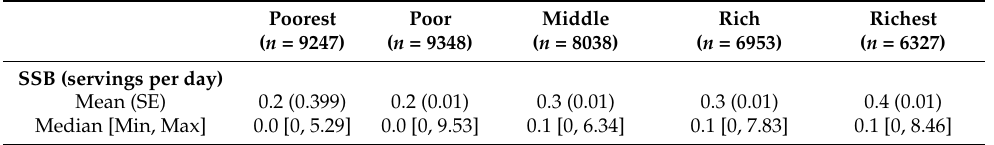
Table 12. Intakes of sugar-sweetened beverages by health status, adults 19 y and